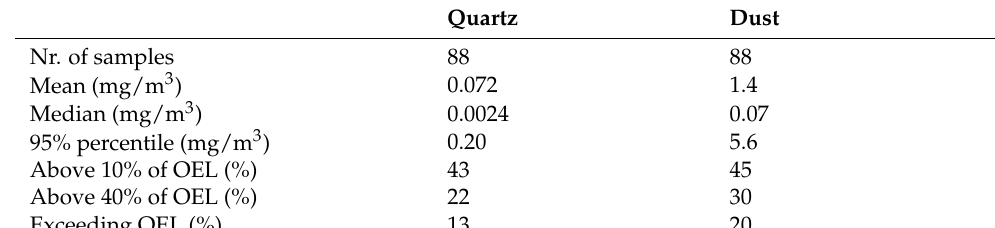
Table 3. Respirable quartz and dust contents of general air on construction sites.